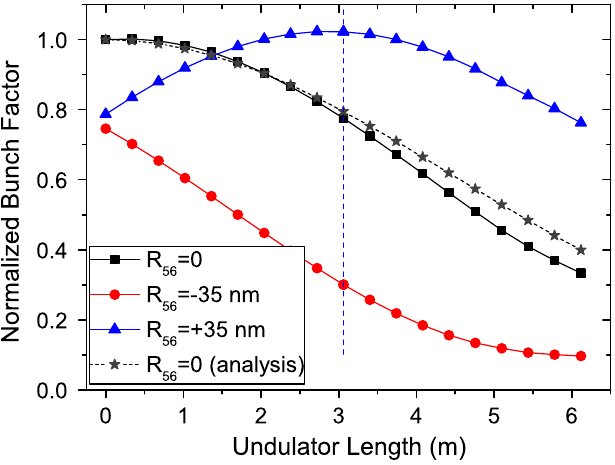
FIG. 9. (Color) Evolution of the bunch factor in an undulator placed after the bending section. Its length is 6 m, the other parameters are given in Table I. Three cases are shown: The black square line denotes R 56 ¼ 0 , the red dotted line denotes R 56 ¼ (cid:2) 35 nm , and the blue triangle line denotes R 56 ¼ þ 35 nm . These results were calculated using GENESIS 1.3 . Analytic results using Eq. (14) for R 56 ¼ 0 are shown by the star